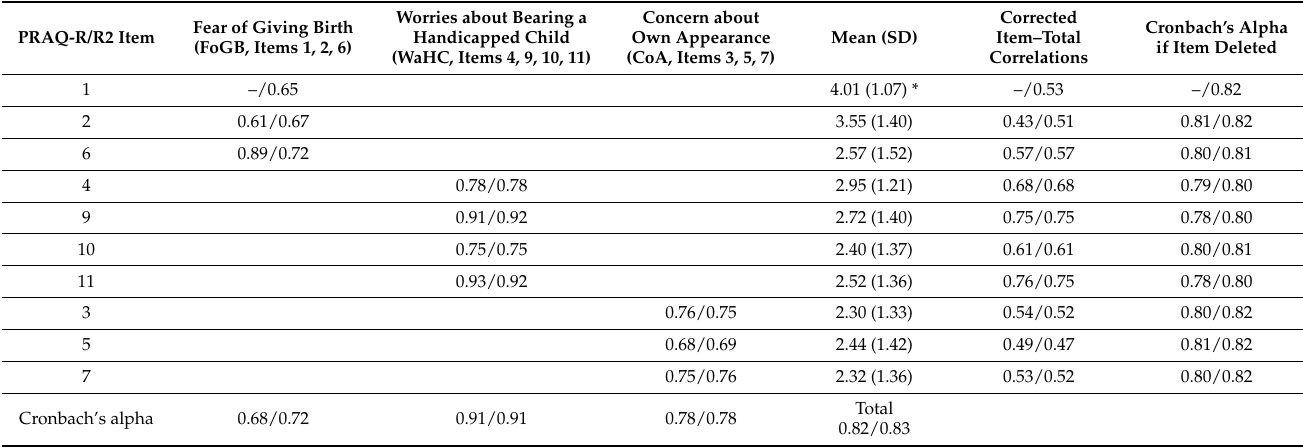
Table 4. Factor loadings and item–total correlations for the PRAQ-R and the PRAQ-R2 in combined groups (PRAQ- R/PRAQ-R2).